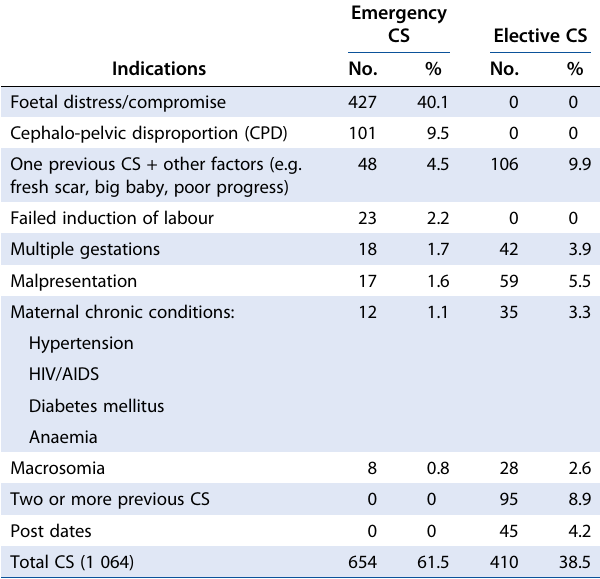
Table 2: Indications for CS in